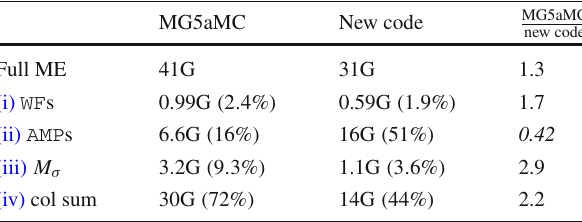
Table1 Thenumberofinstructionstocalculate gg → 5 g for10phase- space points at full colour in standard MG5aMC standalone and in our newcode(atN6LC,i.e.fullcolourandusingBGrecursions).Inaddition to the total number of instructions required to do the calculation (Full ME), we have broken down the calculation into four steps: calculat- ing internal and external wavefunctions ( WF s), calculating completed graphs ( AMP s), putting these graphs into colour ordered amplitudes ( M σ ), and summing over colours (col sum). The number in brackets is the percentage of the total number of instructions required to calculate the Full ME. In the right-hand column we compare the old code and the new one, and use red when the new code is worse than the old one